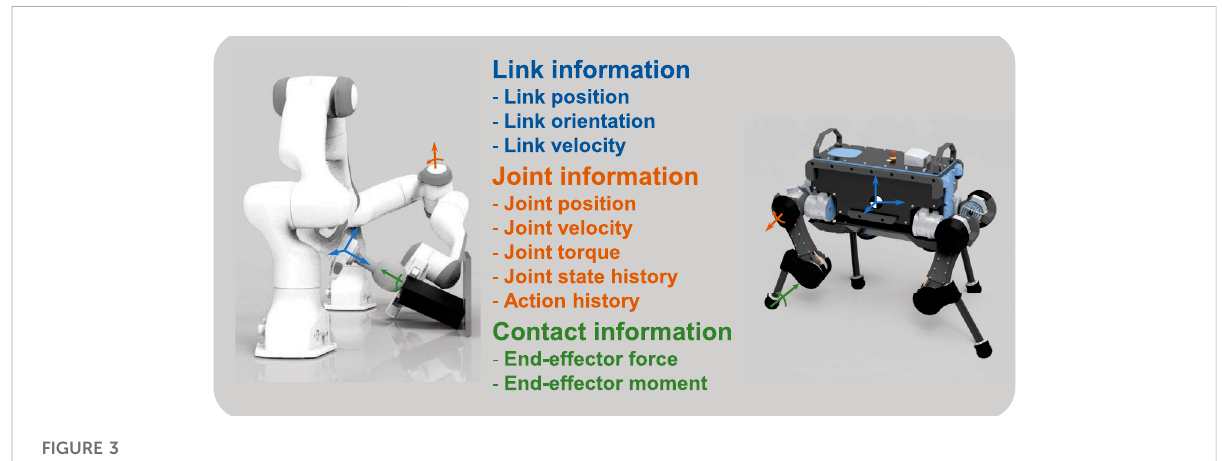
FIGURE 3 Potential state variables as feedback states for locomotion and manipulation